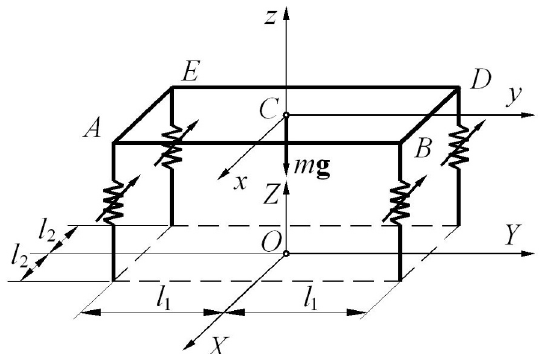
Figure 1. Mathematical